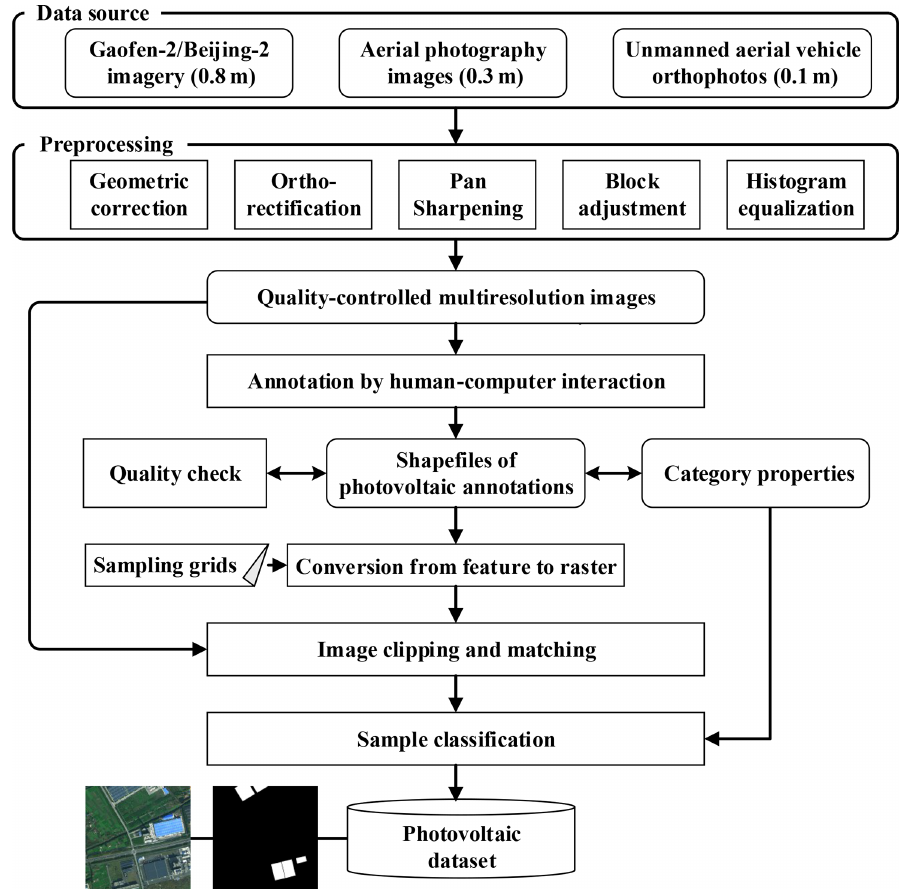
Figure 2. Flowchart to generate PV